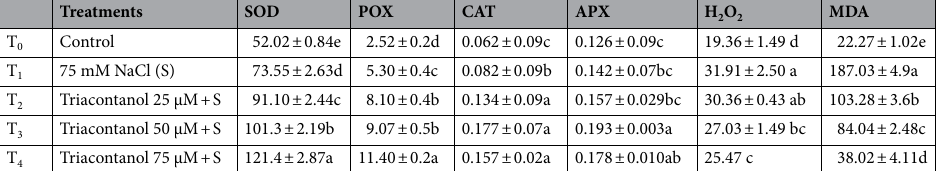
Table 4. Effects of triacontanol spray on antioxidants activities and lipid peroxidation of Hot pepper plants under salt stress. Means sharing the same letter for a parameter, do not differ significantly at p ≤ 0.05; SOD = Superoxide dismutase; POX = Peroxidase; CAT = catalase; APX = Ascorbate peroxidase, MDA = malondialdehyde.